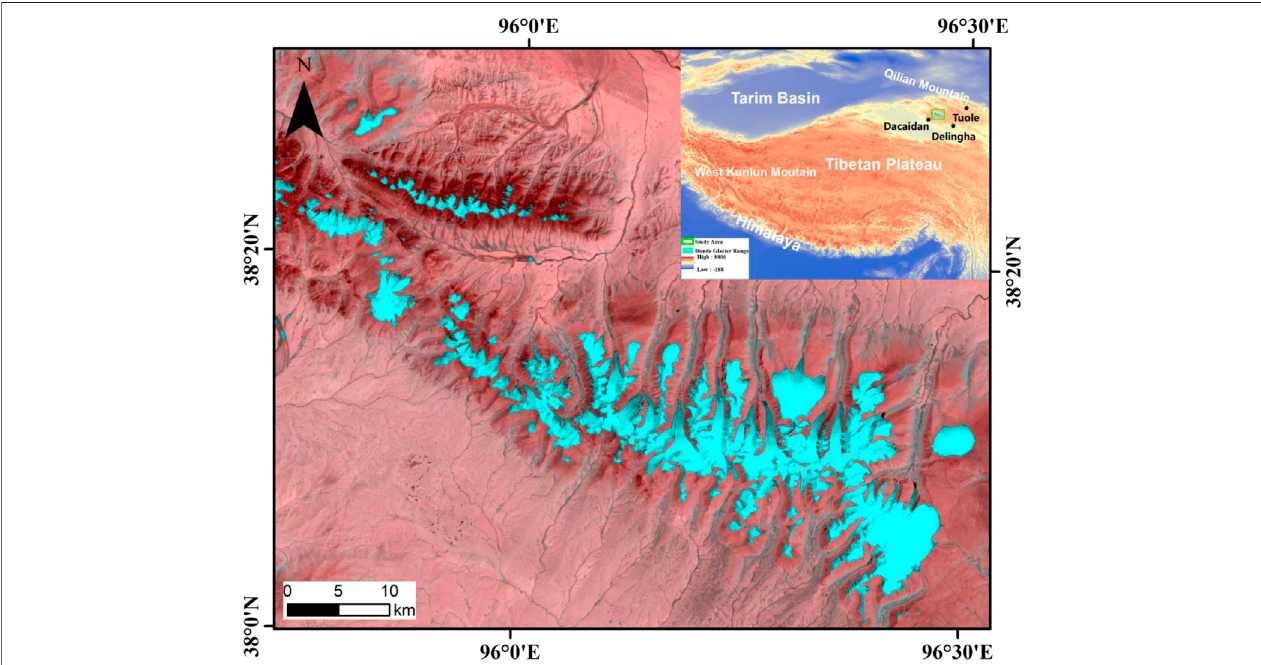
FIGURE 1 | Map showing the study area and the distribution of glaciers.